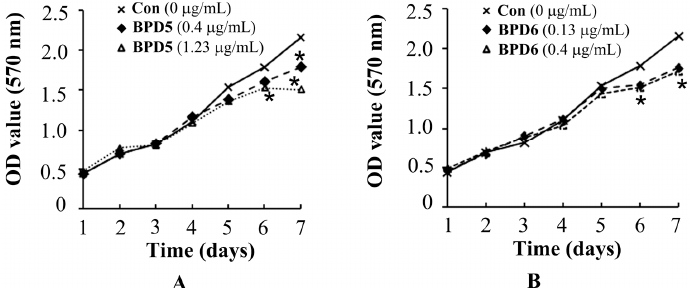
Figure 2. The proliferating rates of SMMC7721 cells in response to BPDs 5 and 6 treatment. Different concentration of 5 (0.4 μ g/mL or 1.23 μ g/mL) and 6 (0.13 μ g/mL or 0.4 μ g/mL) were used to treat cells ( A , B ). At indicated time intervals, the proliferating rate of SMMC7721 cells were determined by MTT assay ( n = 3). *, p <0.05 compared to non-treated controls.